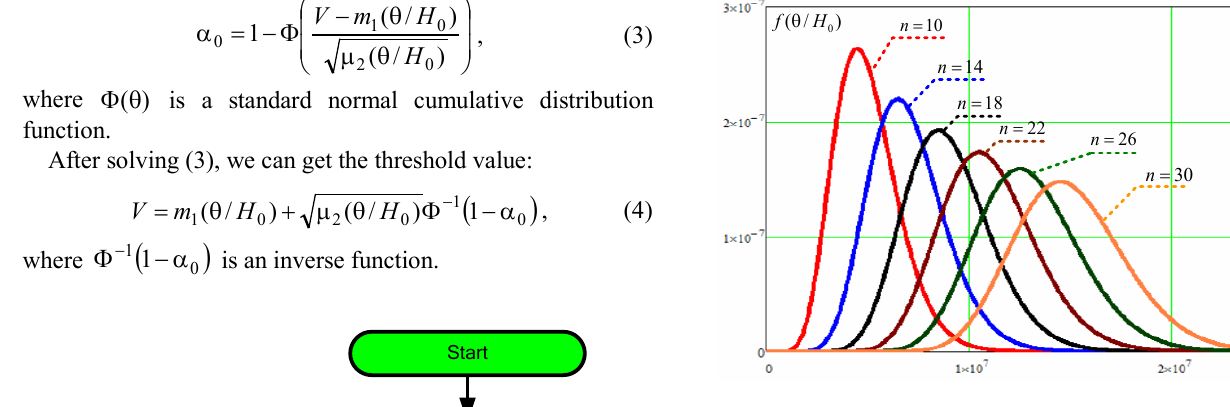
Fig. 3. PDF of decisive statistic for different sample size.